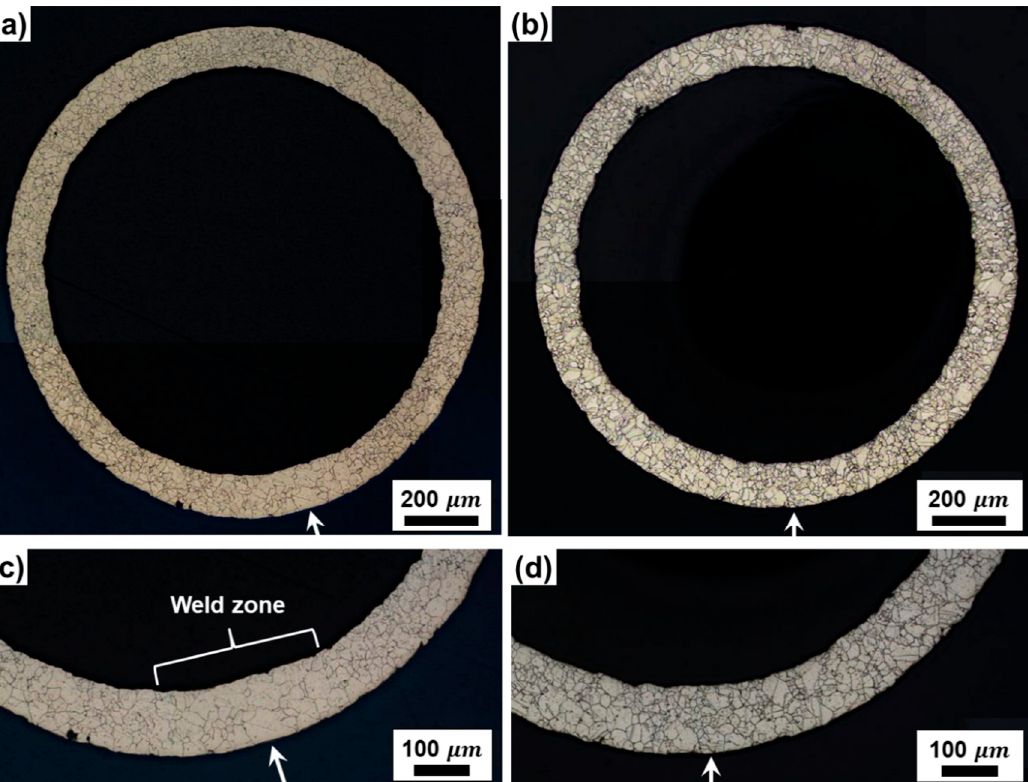
Figure 11. Fracture surfaces for ( a – c) short-life (78,621 cycles) and ( d , e ) long-life (781,887 cycles) specimens tested at 1000 K and σ max = 402 MPa. The arrows in ( a , b , d , e ) indicate the crack initiation sites. ( c ) presents the enlarged image of the area highlighted in ( b ).